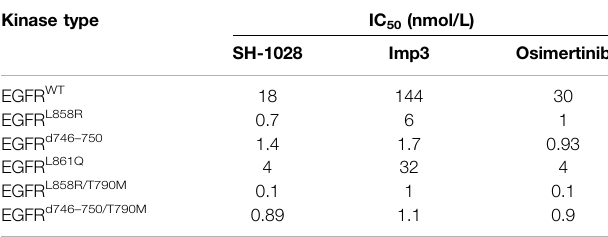
TABLE 1 | Kinase enzymatic assay ( X ; n (cid:1)